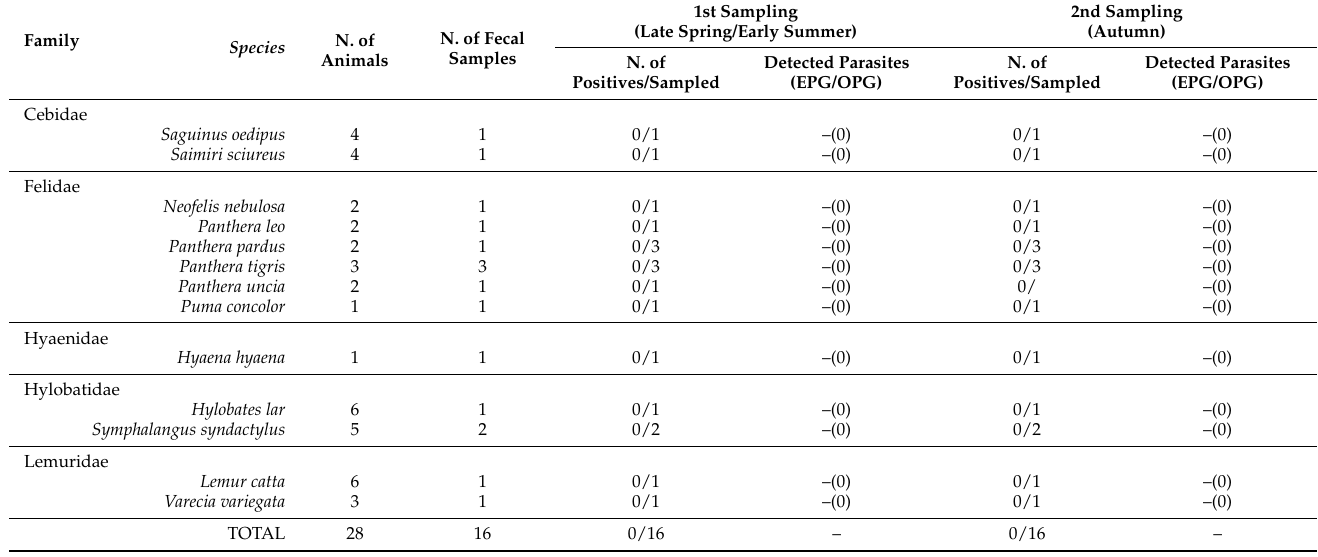
Table 2. Endoparasites detected by quali/quantitative copromicroscopic analyses (FLOTAC ® dual technique) in carnivores and primates from a faunistic park in northern Italy.